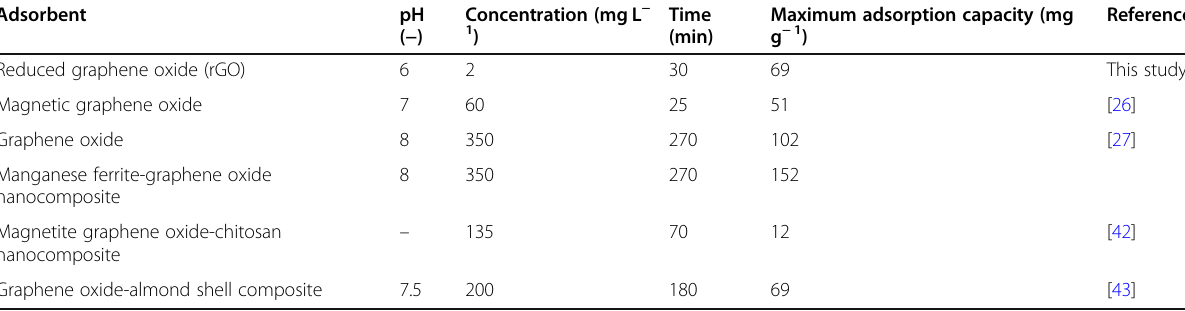
Table 5 Ni (II) adsorption capacity stated in literature studies compared to the present study